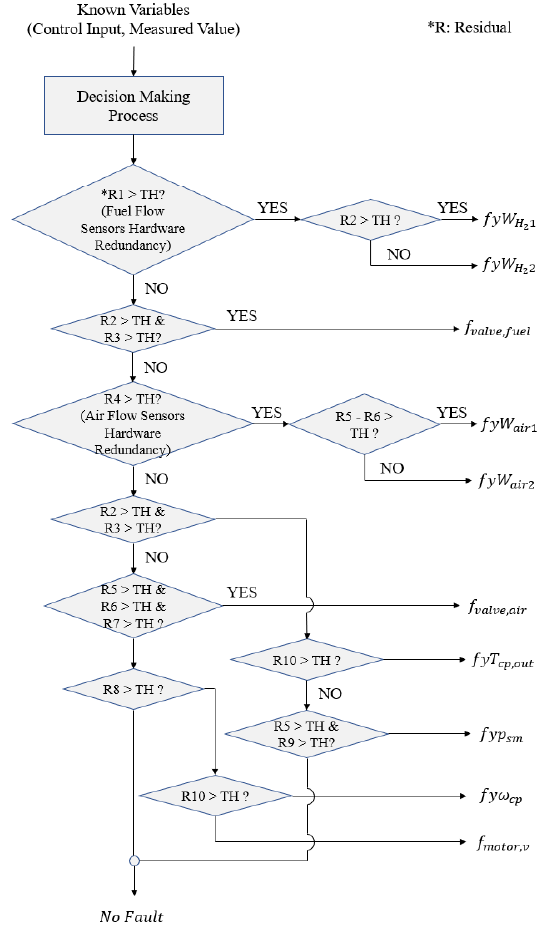
Figure 9. Fault detection and isolation algorithm.